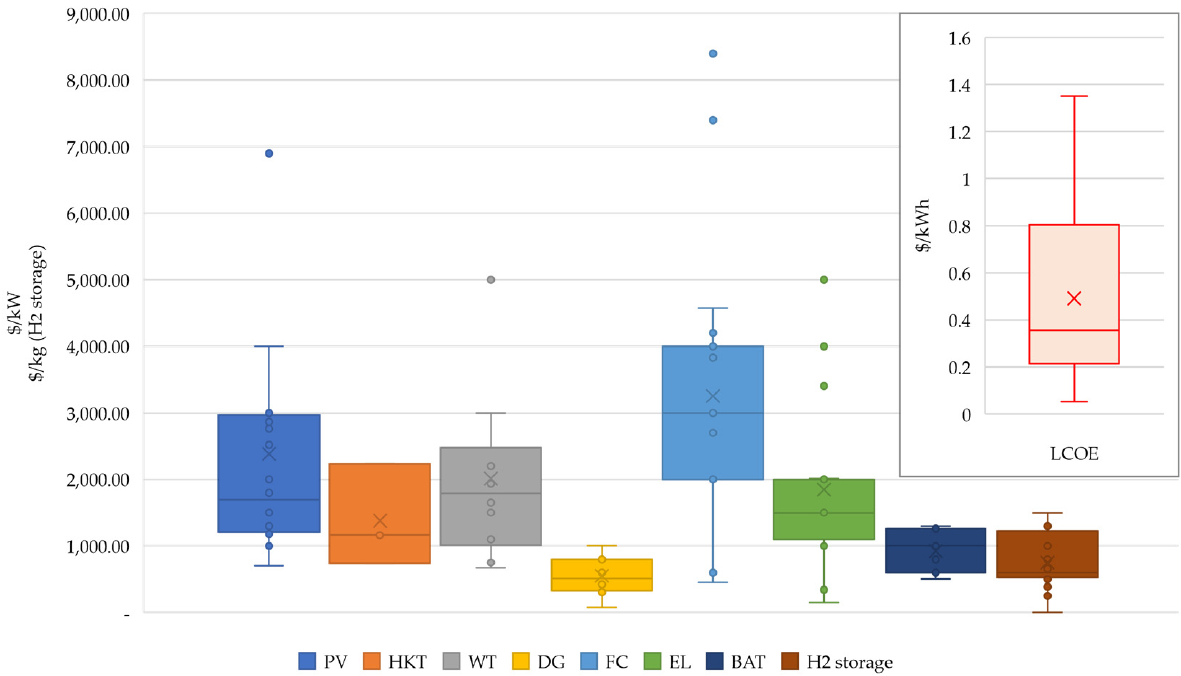
Figure 4. CAPEX of main components and LCOE reported in the literature. Abbreviations: PV = photovoltaic; HKT = hydrokinetic turbine; WT = wind turbine; DG = diesel generator; FC = fuel cell; EL = electrolyzer; BAT = battery; H 2 storage = hydrogen storage.